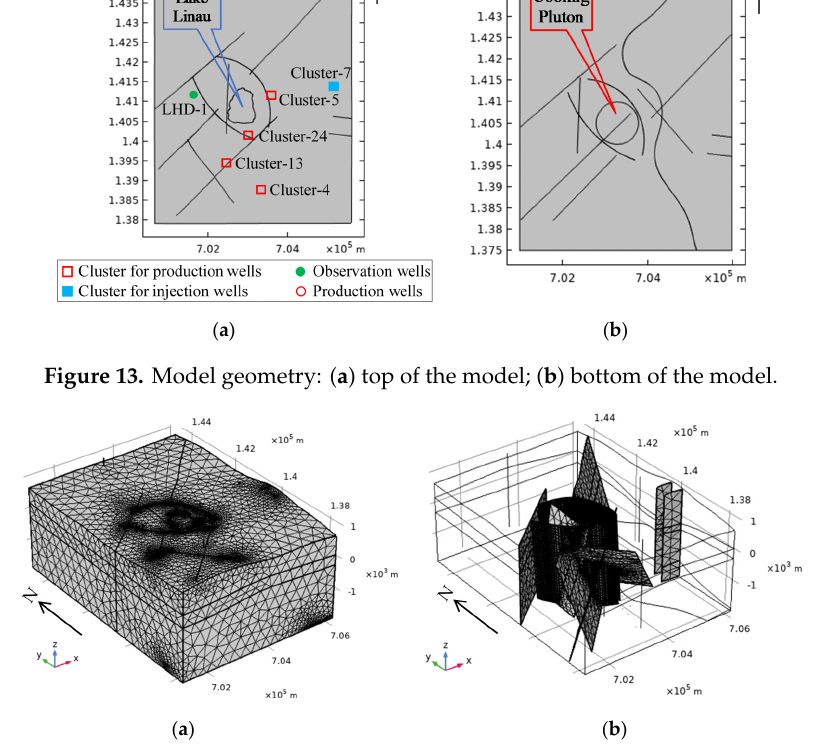
Figure 14. Mesh system in model geometry (tetrahedral elements: 416,850; triangular elements: 65,195): ( a ) rock matrix; ( b ) discrete fractures.